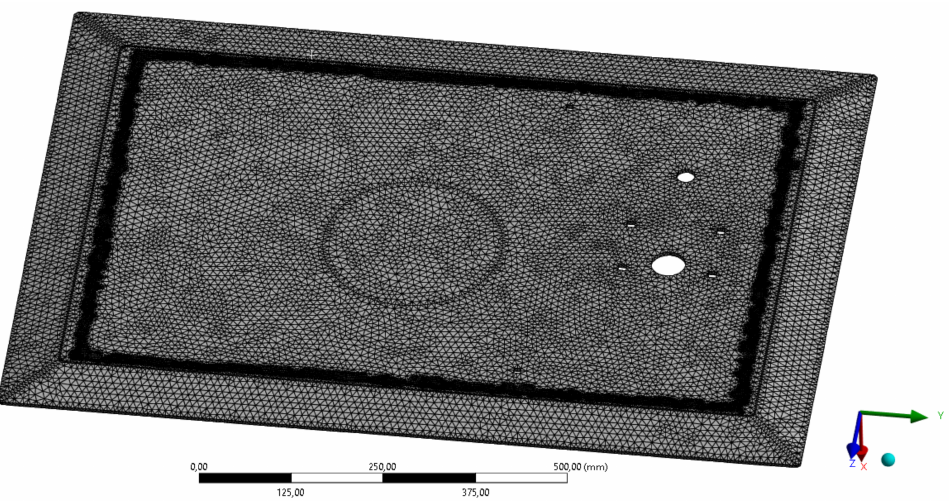
Figure 12. Mesh of the test body of the